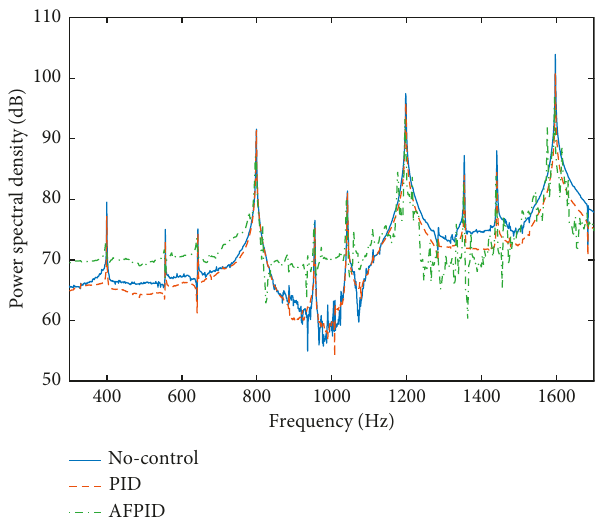
Figure 13: Active control of vibration in the frequency domain of gear transmission